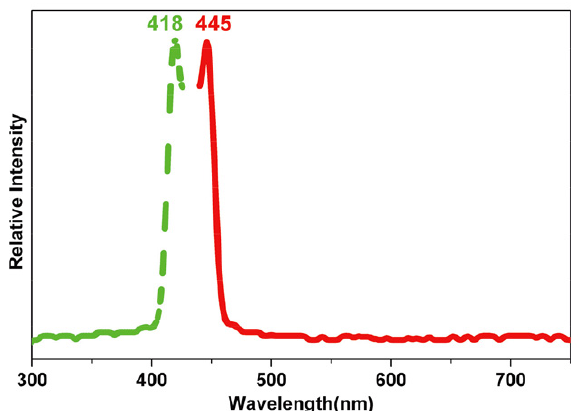
Figure 4. The solid state photoluminescence spectra of compound 1 . Green dashed line: excitation; red solid line: emission.